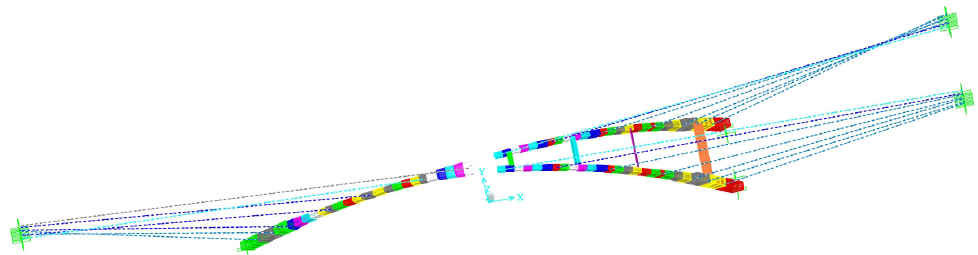
Figure 11. Buckle cables acting on the tower.